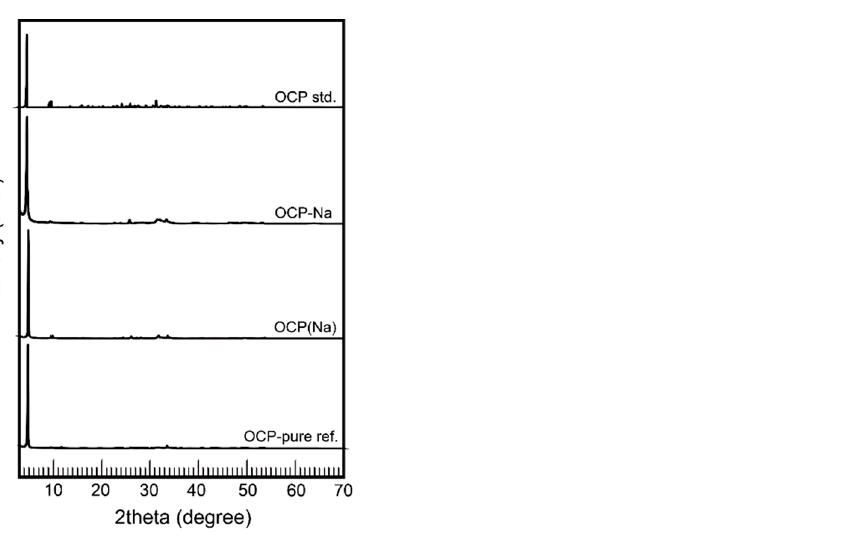
Figure 1. XRD patterns of the treated samples. OCP-Na: DCPD treated in 1 mol/L Na 2 HPO 4 . OCP(Na): CaCO 3 treated in 2 mol/L NaCl and 1 mol/L H 3 PO 4 . OCP-pure: CaCO 3 treated in 1 mol/L H 3 PO 4 . OCP std was calculated by Mathew et al. [28] and the VESTA3 program [30]. Table 2. The initial and final pH values of reacting solutions for each synthesis method.